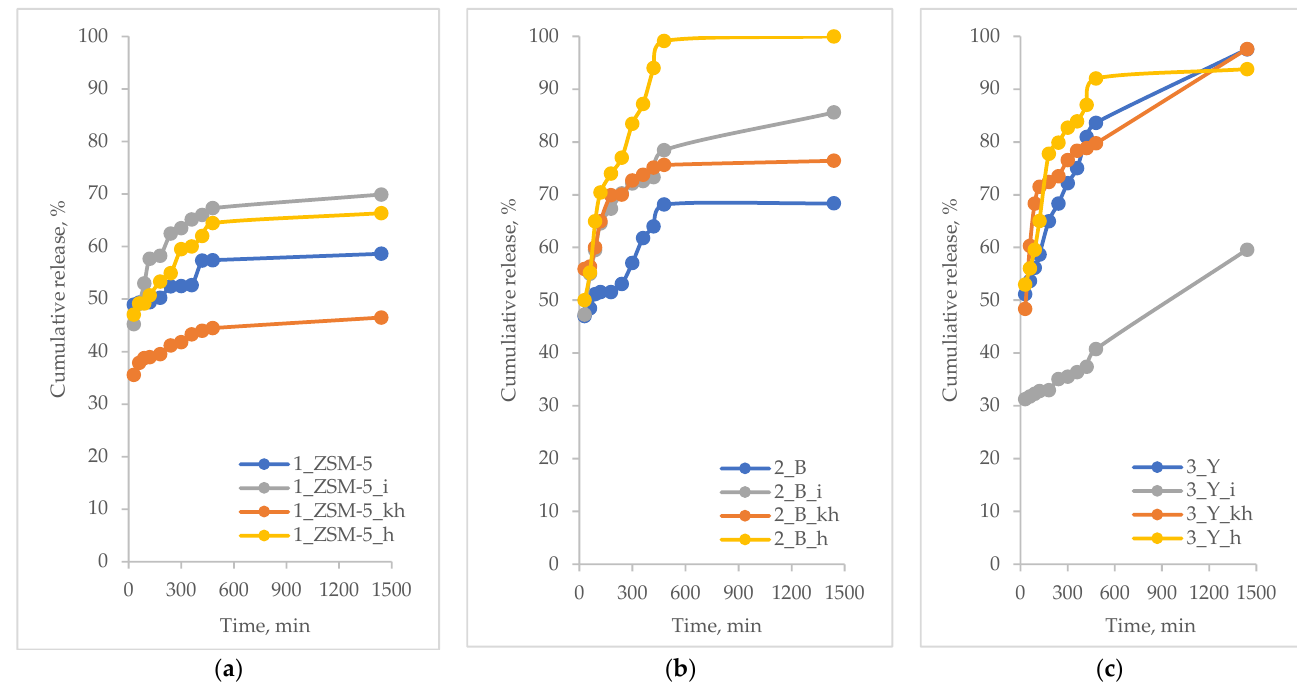
Figure 4. Percentage of ibuprofen released from modified hierarchical zeolites; ( a ) samples based on ZSM-5 zeolite; ( b ) samples based on BEA zeolite; ( c ) samples based on FAU zeolite.